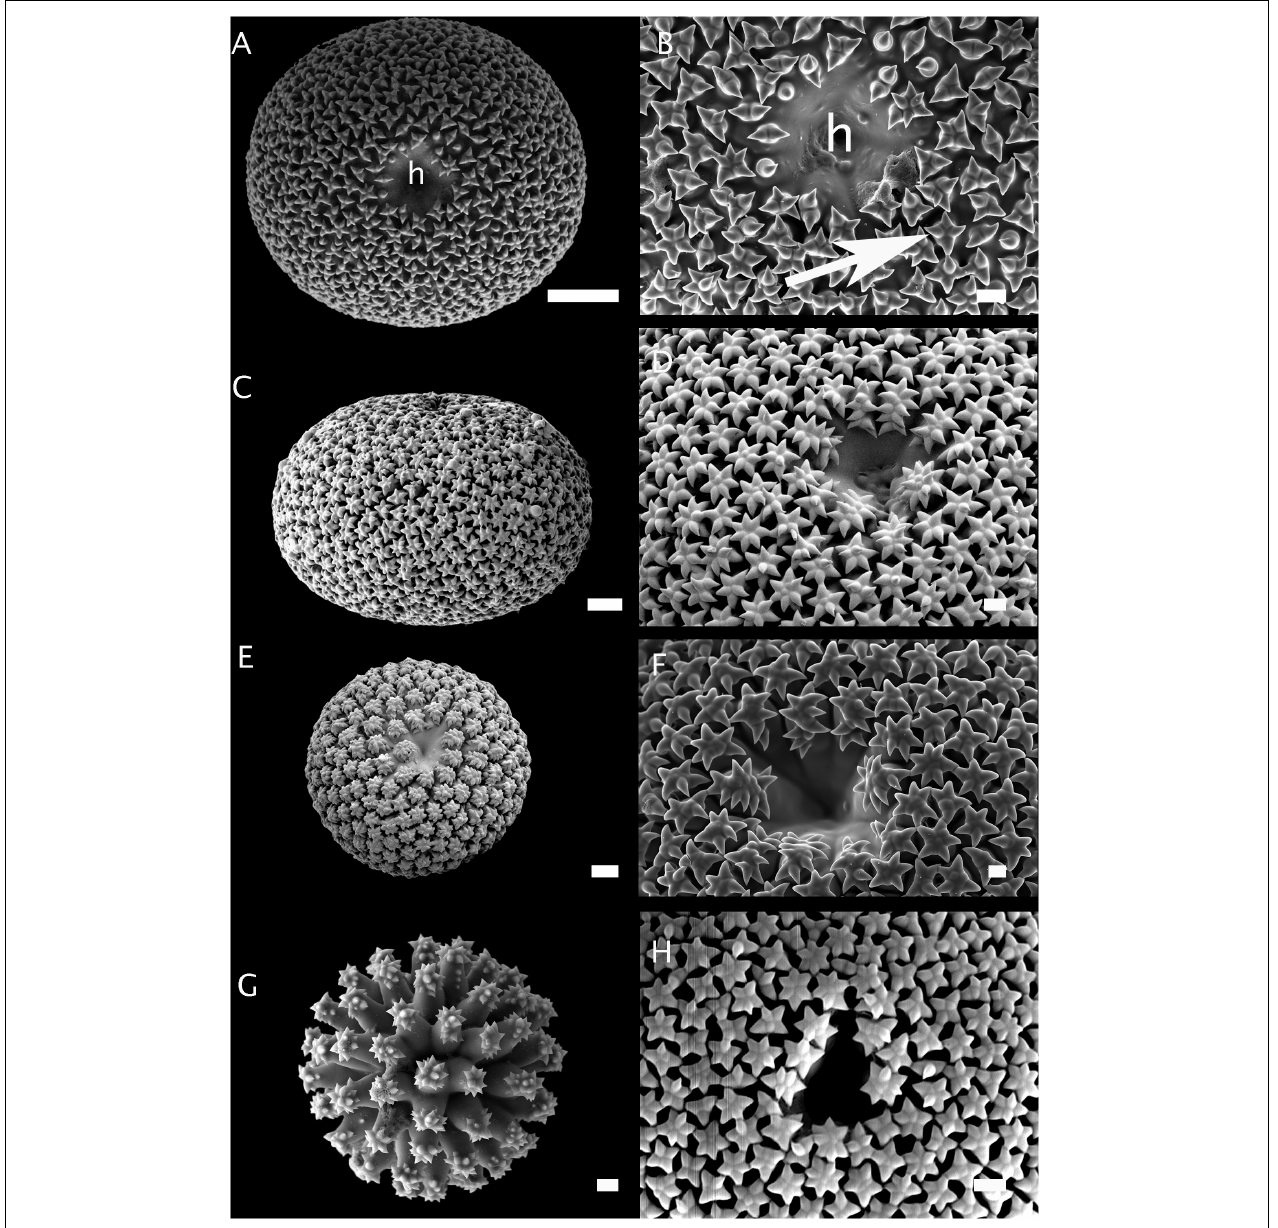
FIGURE 2 | Morphology of sterrasters with smooth rosettes. (A,B) Sterraster of Geodia atlantica (holotype, S.R.151-27/364-1914); (h) is the hilum; the arrow points to a smooth rosette made up of rays. Scale A: 20 µ m. Scale B. 2 µ m. (C,D) Sterraster of Geodia phlegraei (holotype, NHM 1910.1.1.840). Scale C: 10 µ m. Scale D. 2 µ m. (E) Sterraster of Geodia parva (holotype, ZMBN 100). Scale: 10 µ m. (F) Sterraster of Geodia gibberosa (holotype, MNHN-DT 608). Scale: 2 µ m. (G) Sterraster of Geodia cordata, previously called Rhabdastrella cordata (South Australia, SAMA S1026). Scale: 2 µ m. (H) Sterraster of Geodia vaubani (New Caledonia, MNHN-IP-2015-1667). Scale: 5 µ